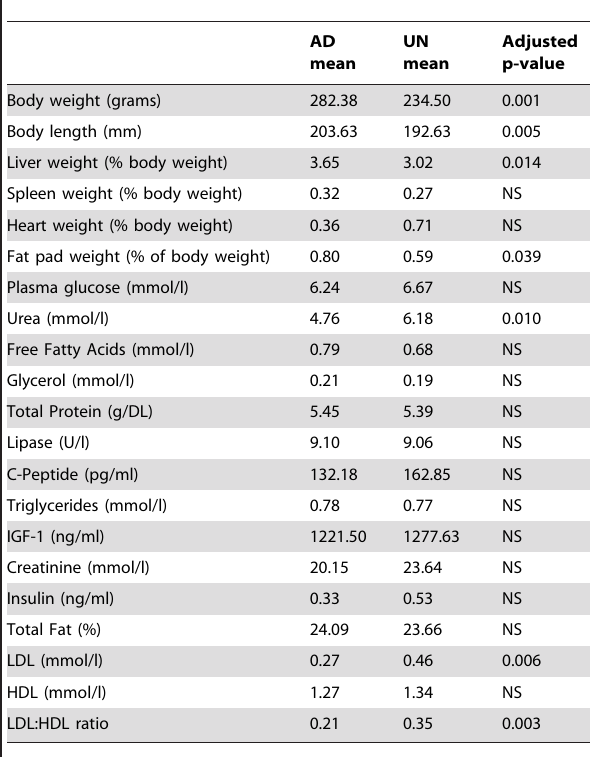
Table 1. Phenotype data, day 55